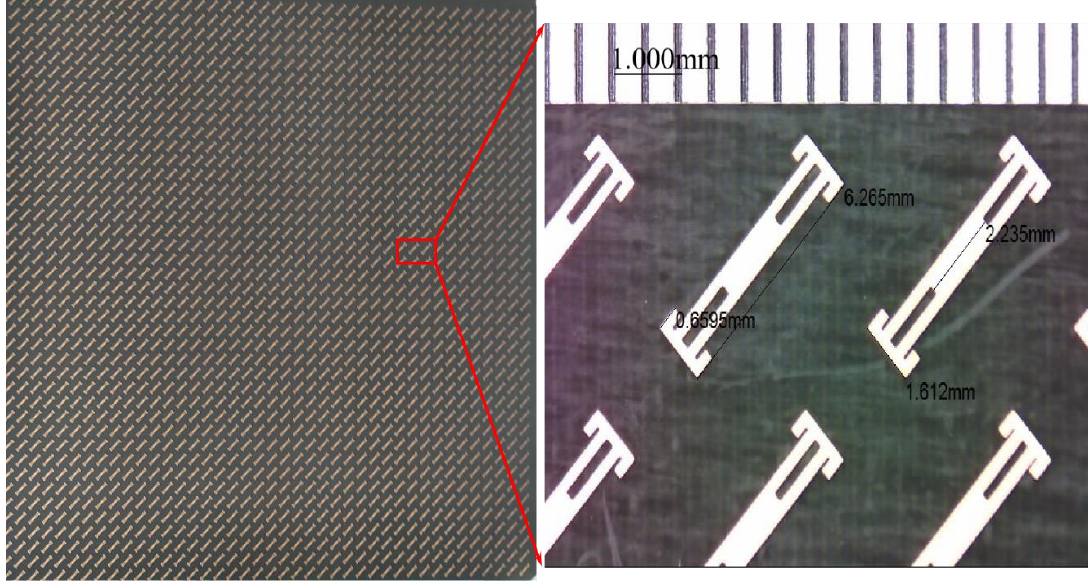
Figure 11. The fabricated sample and its unit cells under an industrial microscope.